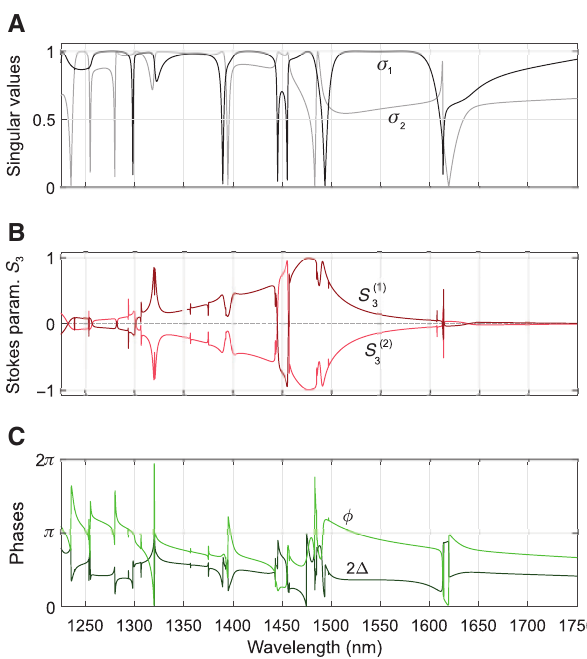
Figure 5: Main quantities arising from the singular value decomposition (SVD) of the metasurface transmission matrix at normal incidence. Panel (A), singular value spectra. Note that the singular values structures recall the features observed in the transmittance, circular polarization differential transmittance and electromagnetic chirality spectra (Figures 1 and 3). Panel (B), third component of the Stokes parameter of the right singular vector. (1,2) S correspond, respectively, 3 to singular values σ . Panel (C), relative phase 2 Δ (i.e. phase 1,2 between right singular vectors) and absolute transmission phase φ